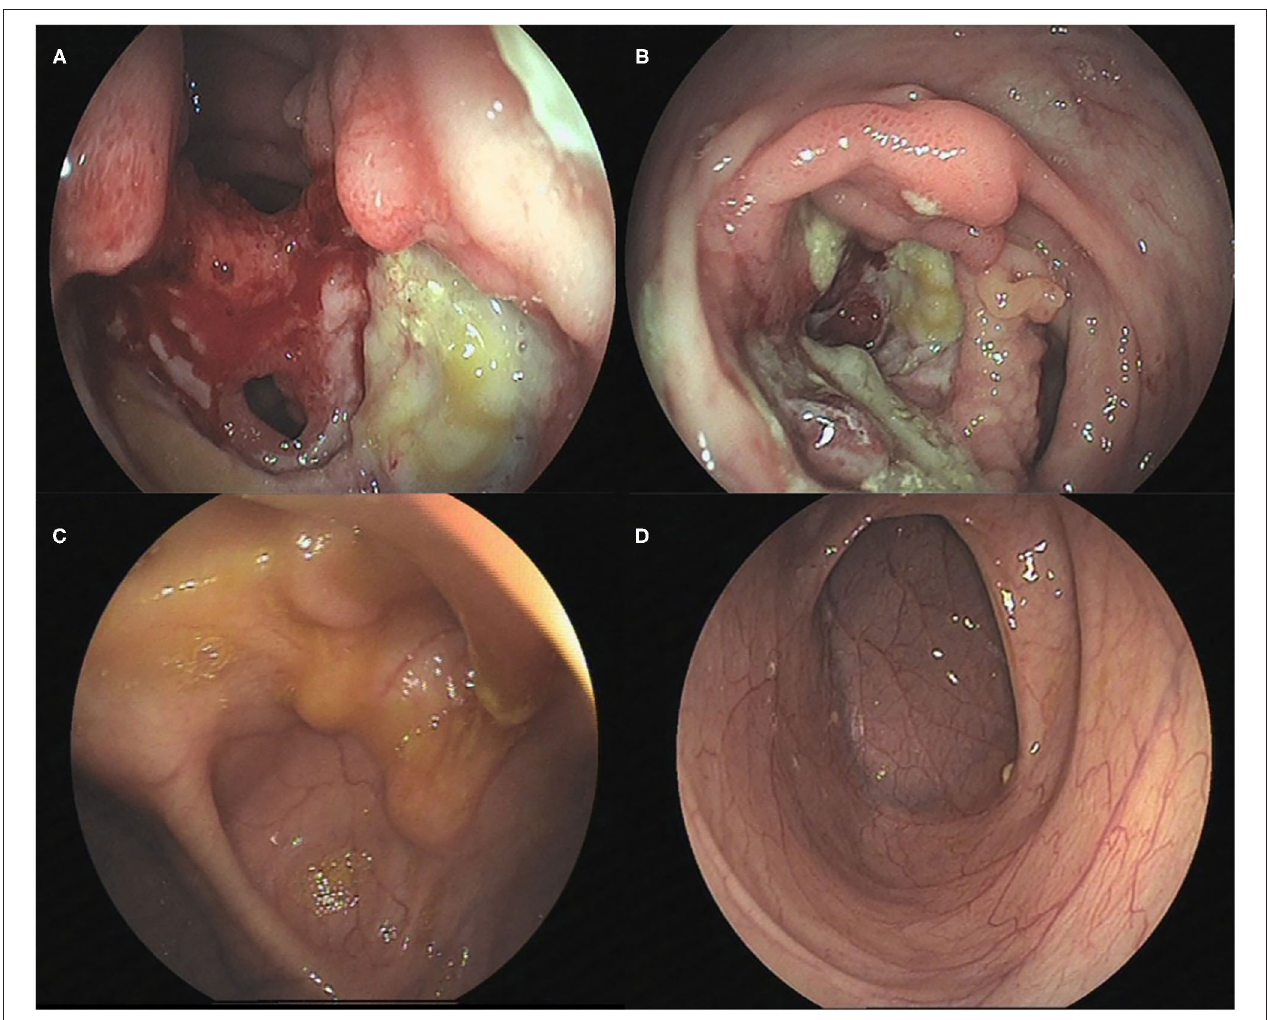
FIGURE 1 | Colonoscopic changes in the patient. (A) The terminal ileum was covered with white moss with a large and flaky ulcer accompanied by erosion. (B) The mucosa was hyperemic and edematous, with a perforated intestinal wall with a diameter of ∼ 1.5cm. (C) Scattered inflammatory polypoid changes were observed in the mucosa around the ileocecal valve mouth, without erosion or ulcer, whereas the morphology of the ileocecal valve was deformed. (D) No abnormalities were observed in the mucosa of the terminal